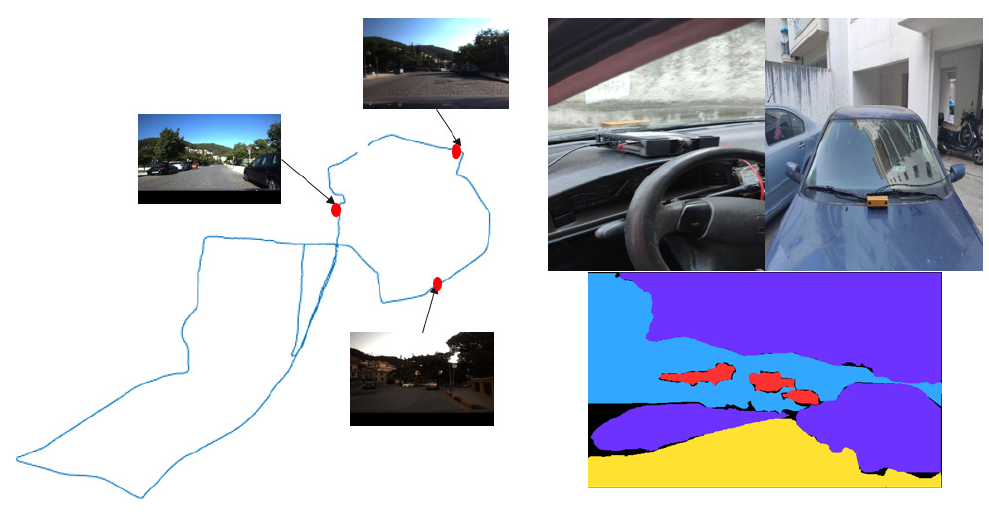
Figure 2. Visualisation of the proposed Gryphon urban dataset, together with the hardware set-up and vehicle used for its creation. Additionally, some images from the route with the corresponding semantic information are